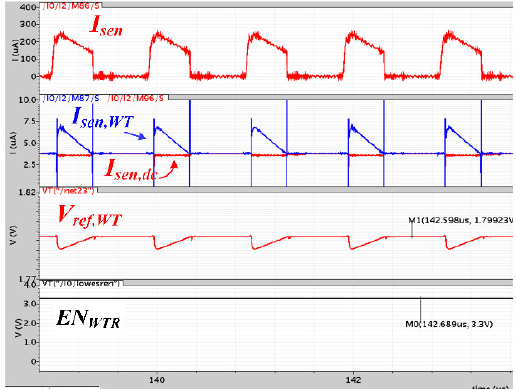
Figure 10. Chip microphotograph.